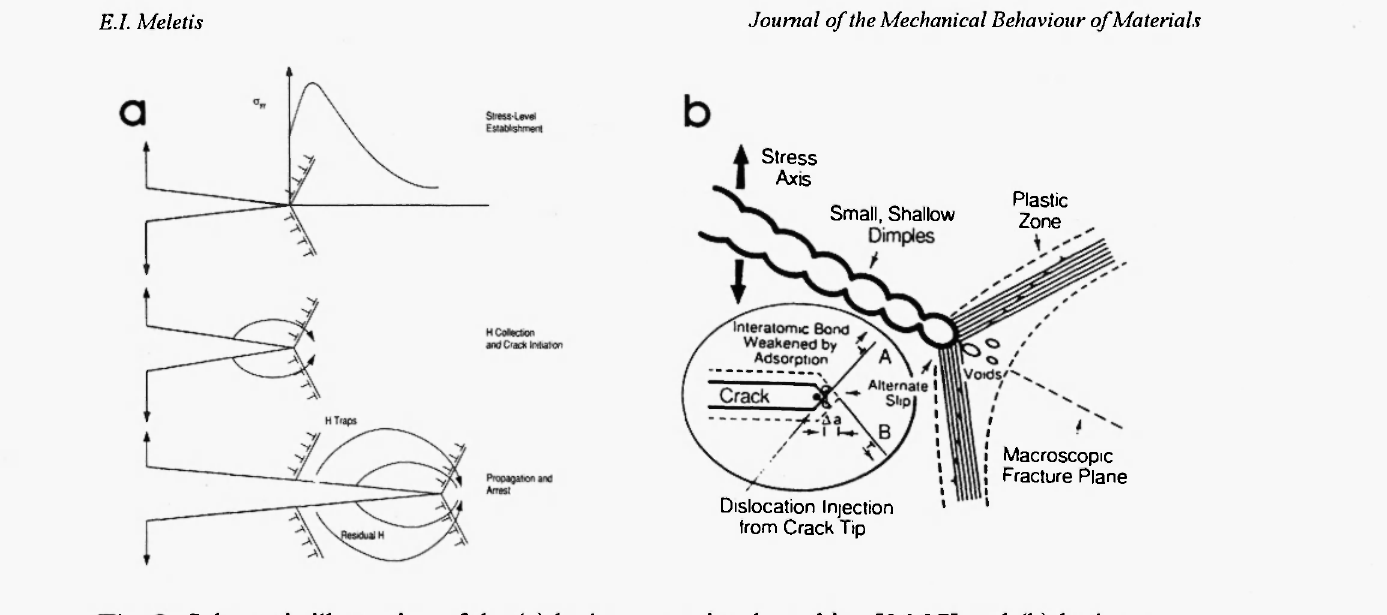
Fig. 3 Schematic illustration of the (a) hydrogen-assisted cracking [26,27] and (b) hydrogen- induced plasticity model [4], alternate slip which promotes the coalescence of cracks with small voids nucleated just in front of the crack. The attractive element of this mechanism is that it can predict high crack velocities in materials with low hydrogen diffusivities and is applicable to many environment- sensitive fracture phenomena (SCC, HE, corrosion-fatigue and liquid-metal embrittlement).